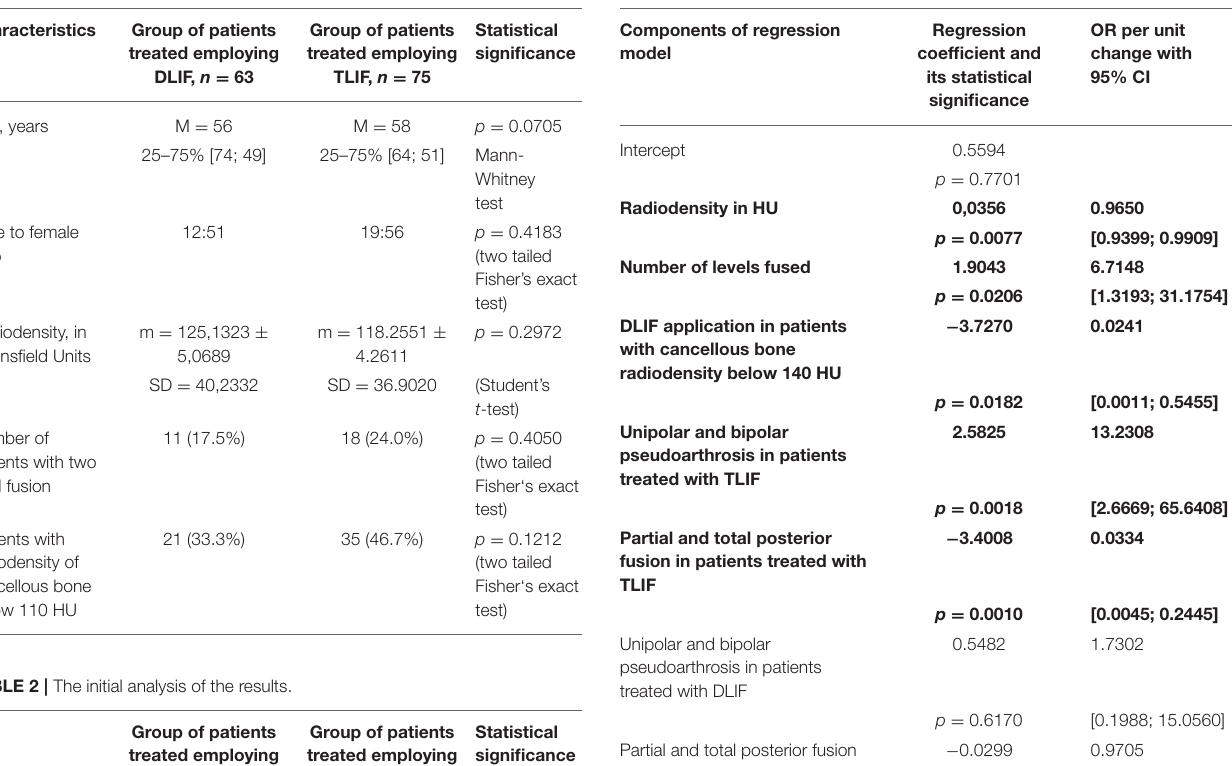
TABLE 3 | Parameters of the estimated logistic regression